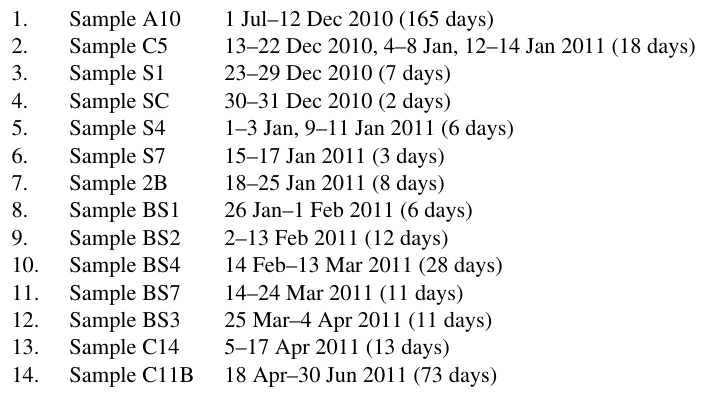
Table 1. Samples used for monitoring (only those listed used during the active